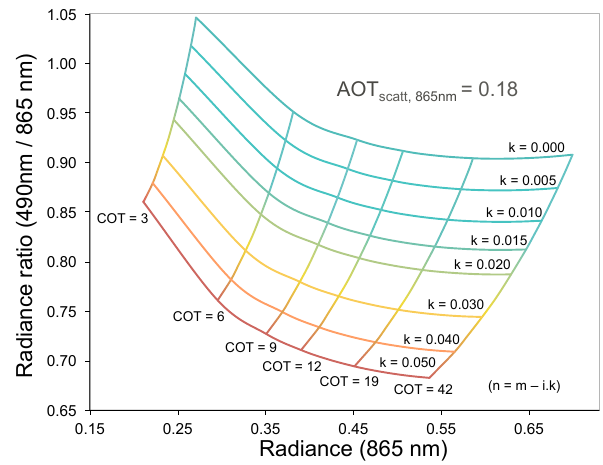
Figure 3. Radiance ratio L 490nm /L 865nm as a function of the ra- diance at 865nm. Signals have been simulated for aerosols with an effective radius of 0.10µm, an effective radius of cloud droplet of 10µm (for more information about aerosol and cloud properties and vertical distribution, see Table 1, total radiance LUT column). The scattering AOT is set and several absorption AOT and several COT values are considered. Calculations have been carried out for a solar zenith angle θ s = 41.3 ◦ , a viewing angle θ v = 41.3 ◦ and a relative azimuth ϕ r = 180 ◦